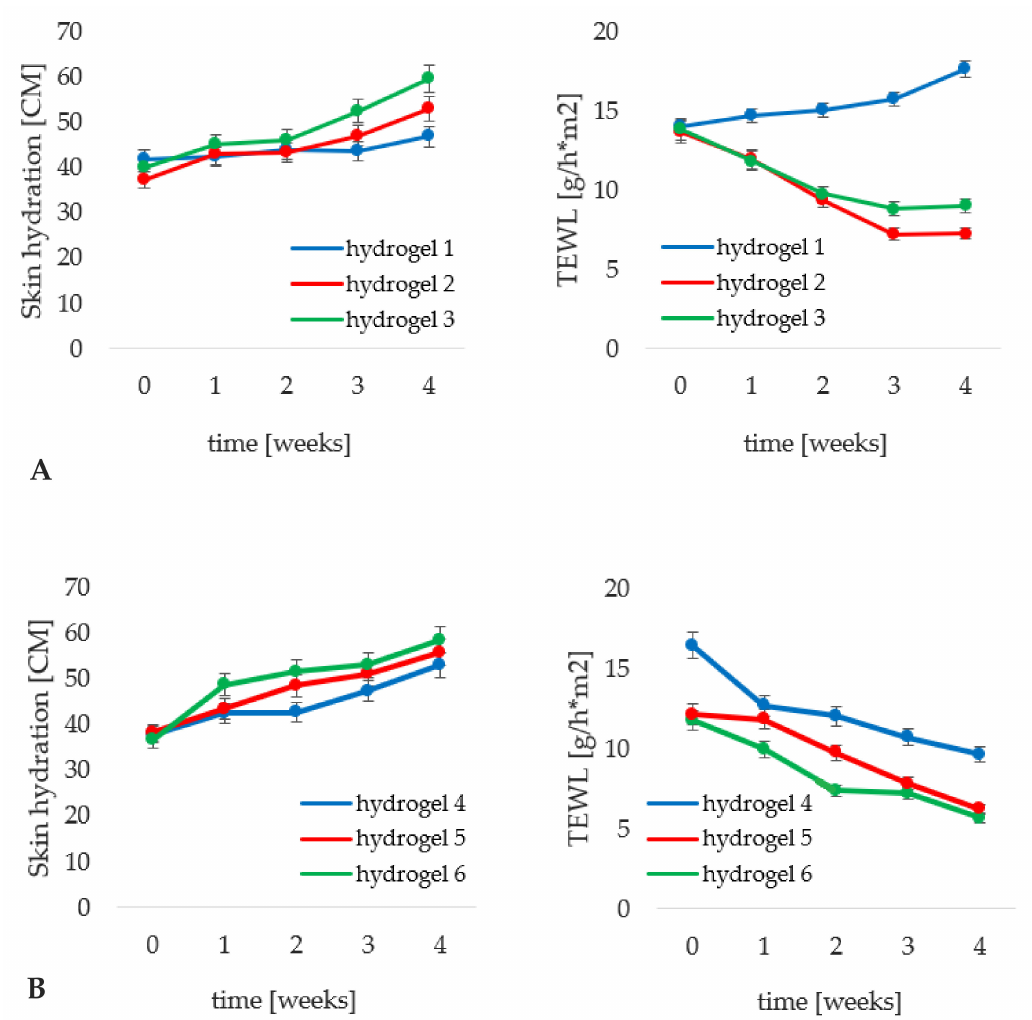
Figure 11. Changes in skin hydration and transepidermal water loss determined for the hydrogel formulations 1–3 ( A ) and 4–6 ( B ) during in vivo studies; p <